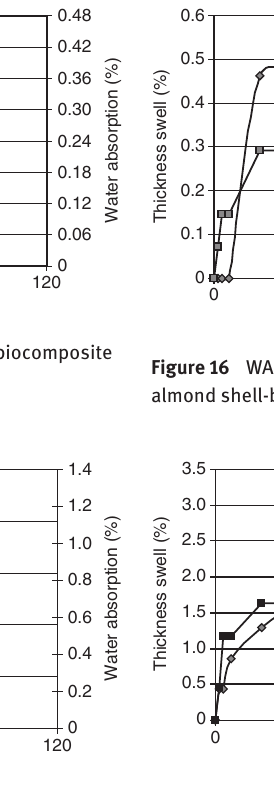
Figure 17 WA and TS for 6 wt% coconut fiber mixed with 20 wt% almond shell-based biocomposite in RW.